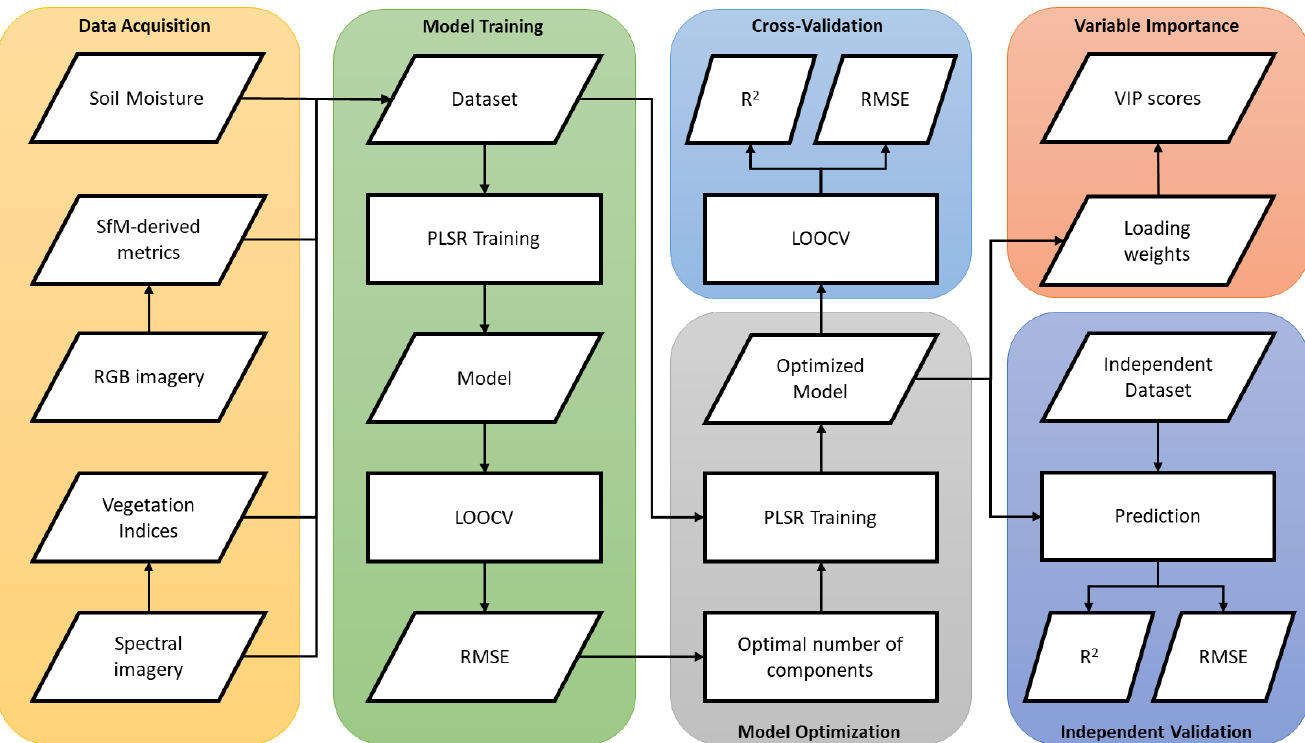
Figure 2. Simplified flowchart of the methodological framework used in this study. It illustrates the input data obtained at the data acquisition tasks, model fitting, optimization and validation (i.e., cross-validation and independent validation), and the outputs of each step of the partial least squares regression (PLSR) implementation; SfM = Structure-from-Motion, RGB = red-green-blue, LOOCV = leave-one-out cross-validation, RMSE = root-mean-squared error, and VIP = variable in- fluence in projection.